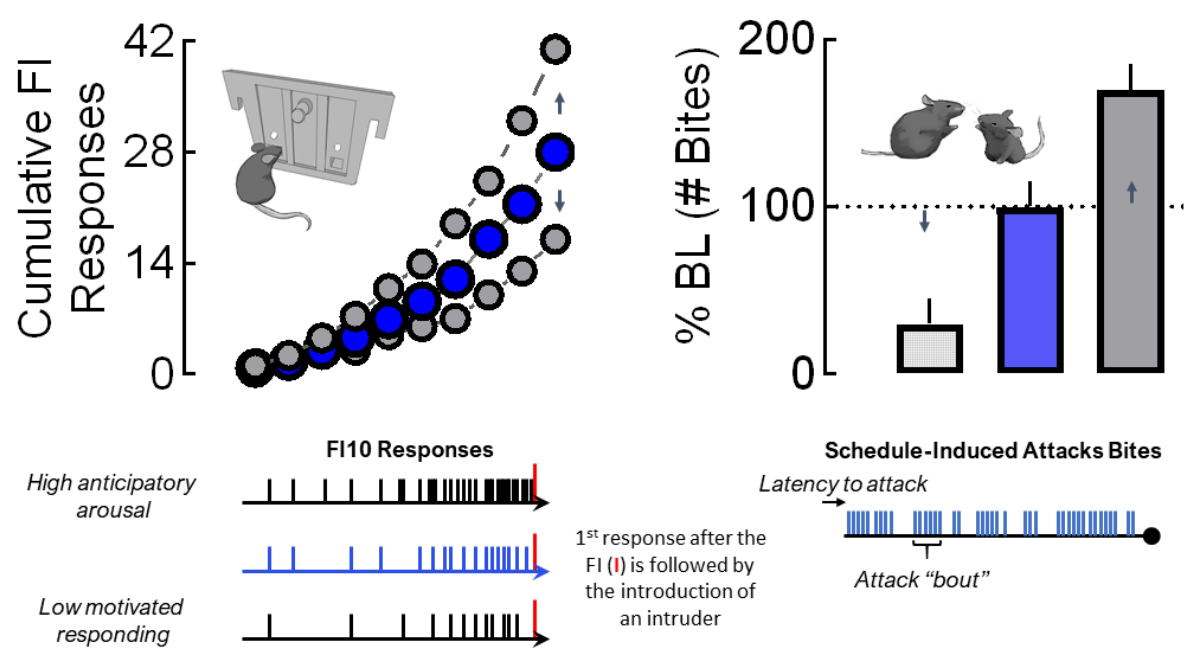
Figure 1. The sequence of experimental events for establishing individual levels of motivated responding for aggression and fighting performance during a daily fixed interval (FI) trial for aggression reward. Prior to their confirmation of territorial aggression, resident male mice are initially housed with females for at least 1 month. In subsequent daily resident–intruder confrontations, each resident male encounters a novel male intruder for less than 5 minutes in the resident’s home cage. After establishing an aggressive phenotype, each resident is trained during a daily FI schedule that is reinforced by the presentation of an intruder (delivered into the resident’s home cage). The duration of the FI is progressively increased from 1 second to 10 minutes over the course of about a month. Resident mice then are allowed to establish a consistent pattern of FI responding. The upper left panel displays typical FI10 scalloped patterns of responding by mice for an aggression reward. Individual responses (tick marks) that are typically generated during a 10-min FI are indicated at the bottom left for varying levels of anticipatory arousal. The first response initiated after the completion of the FI allows the introduction of an intruder into the resident’s home cage. The upper right panel displays one element of fighting behavior (attack bites) that can be examined and potentially altered by experimental manipulations. Other aggressive elements that can be quantitatively and qualitatively examined include the latency to a first attack, number of attack bouts (bottom right), and biting topography (not shown). Changes in appetitive motivational responding can occur with or without alterations in fighting